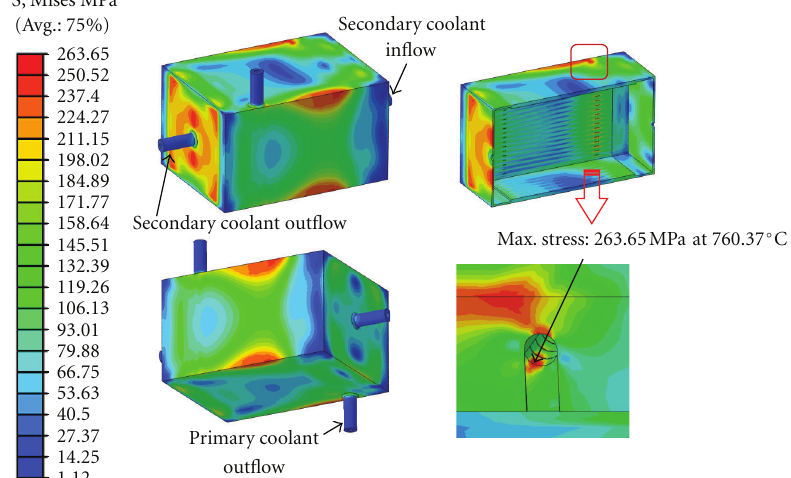
Figure 16: Overall stress contours of a 10kW class PHE prototype from an elastic-plastic analysis using the parent material properties [12].